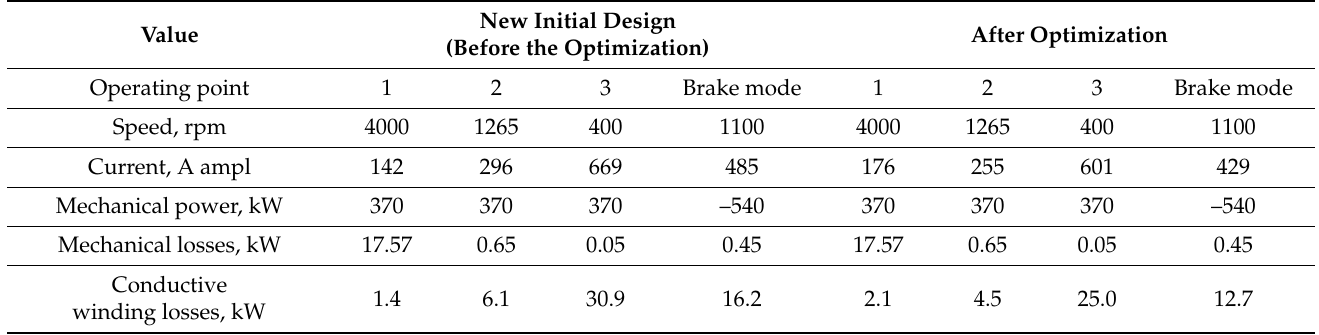
Table 7. Optimization